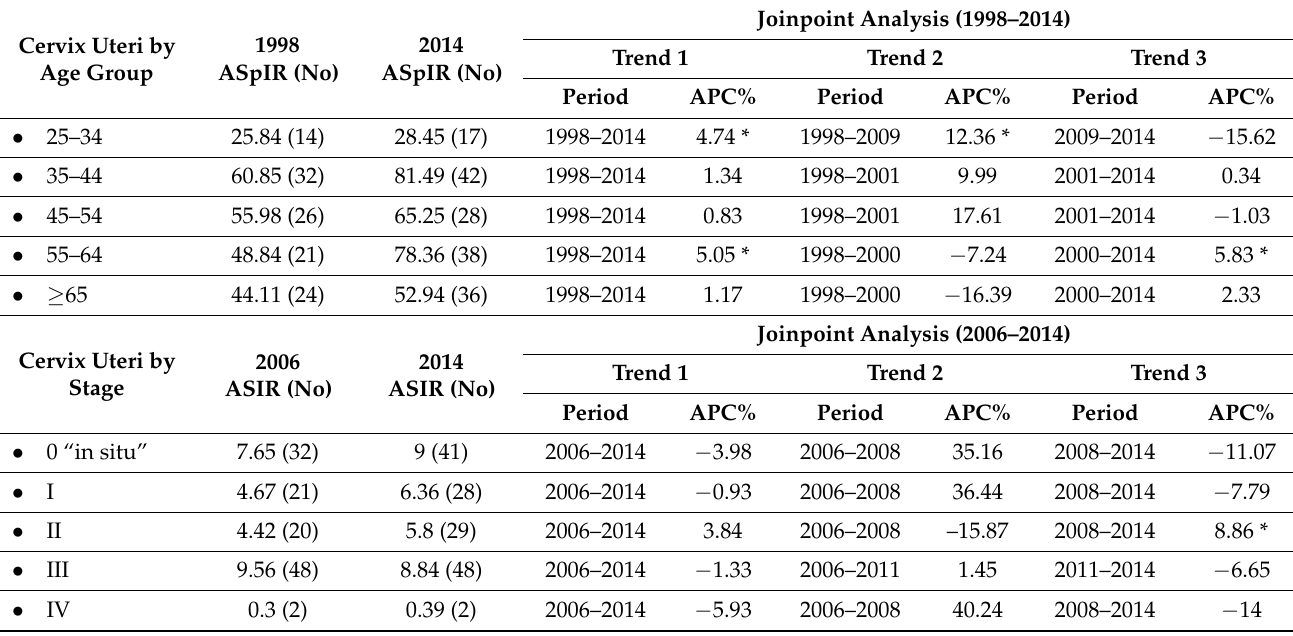
Table 3. Time trends of the age-specific incidence rates (ASpIR) (cases/100,000), 1998–2014, and of the age-standardized incidence rates (ASIR) (cases/100,000) by stage, 2006–2014, Cluj County.